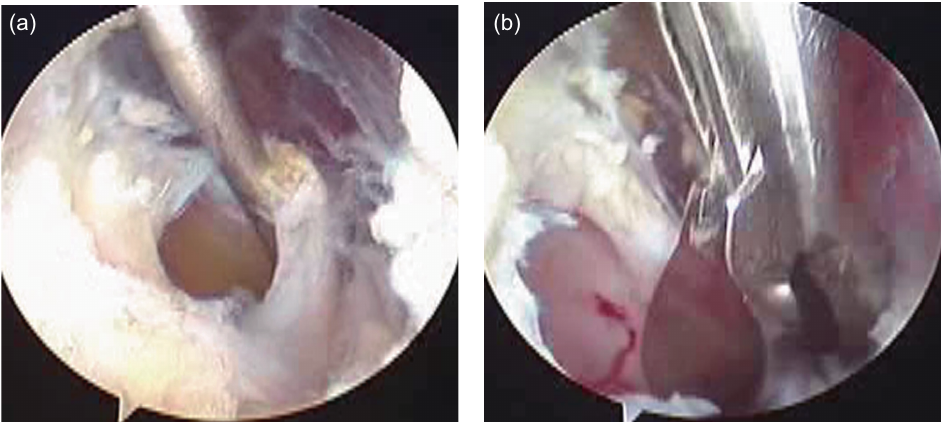
Figure 3. Arthroscopic imaging demonstrating decompression of the spinoglenoid cyst through the released superoposterior capsule (a), and partial removal of the cyst using an arthroscopic punch